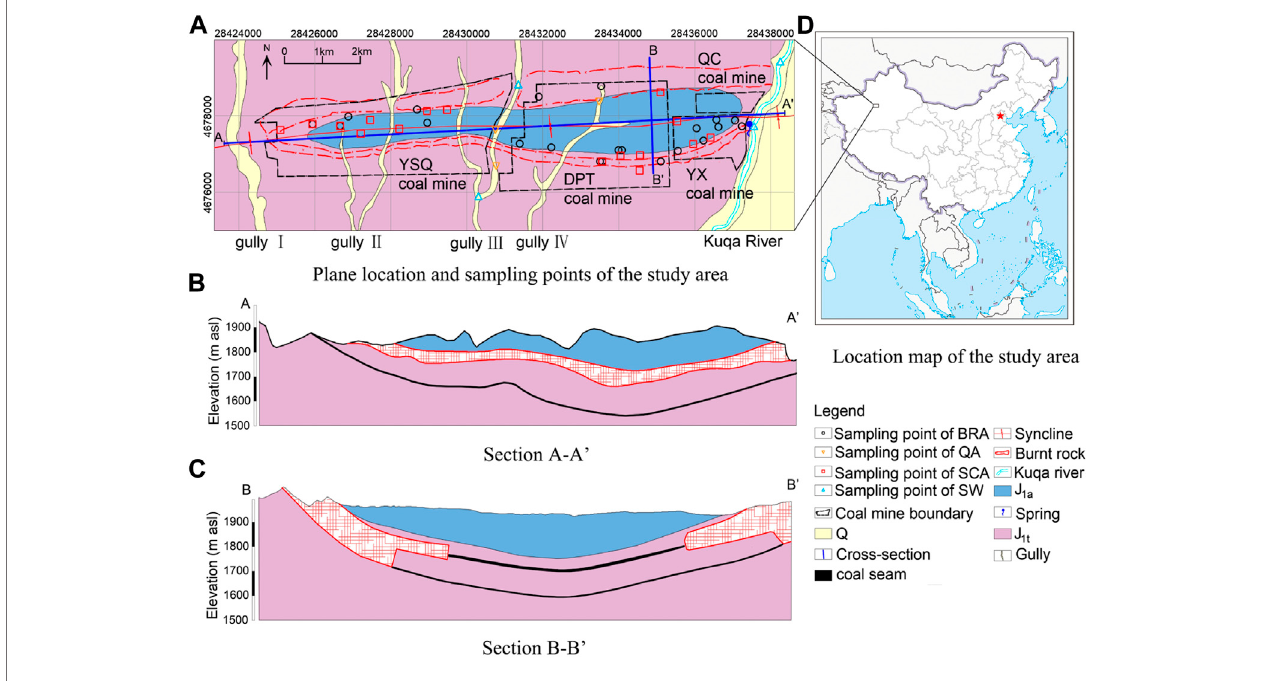
FIGURE1| Generalinformationaboutthestudyareaandwatersamplingsite (A) theplanelocationandsamplingpointsofthestudyarea; (B) thesectionA-A ’ ; (C) the section B-B ’ ; (D) the location map of the study area.